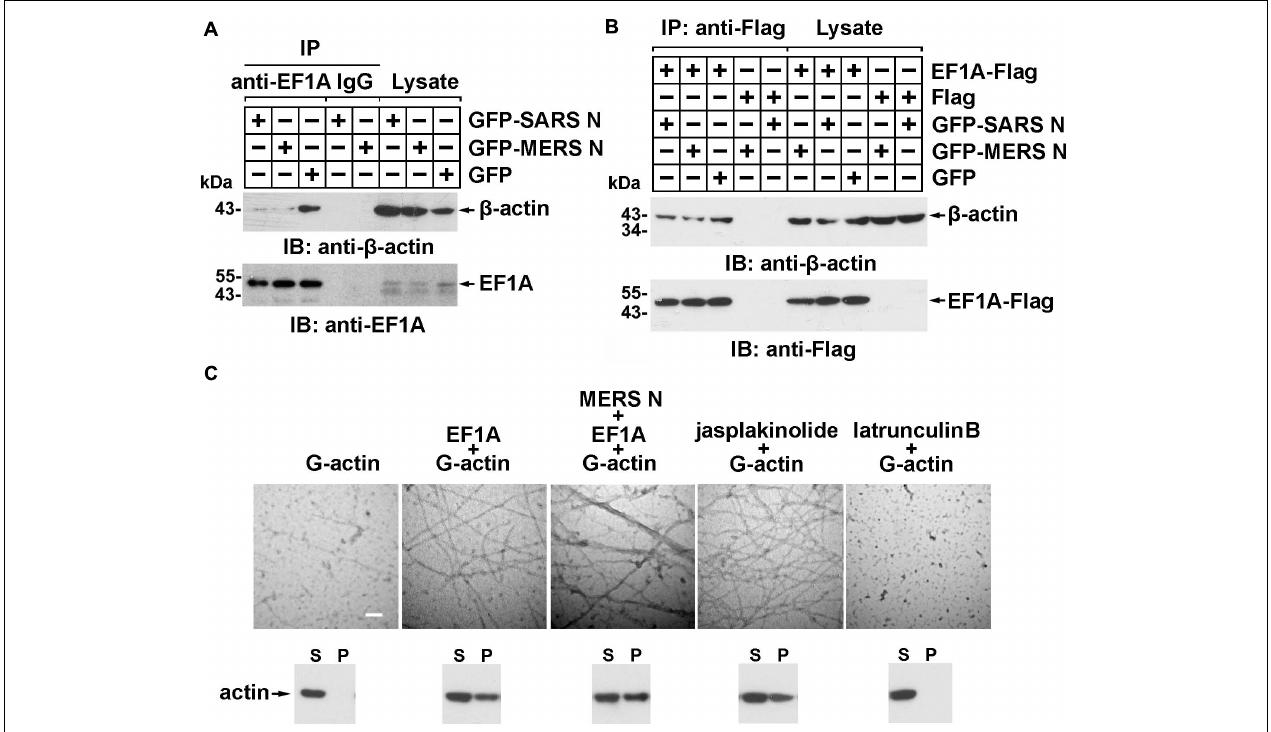
FIGURE 4 | The MERS-CoV N protein blocks the interaction between EF1A and actin and disturbs actin bundling. (A) Lysates prepared from HEK293T cells transfected with plasmids expressing GFP-SARS-CoV N, GFP-MERS-CoV N, or GFP protein were incubated with an EF1A antibody and protein A/G agarose beads. The immunoprecipitates were detected by immunoblotting with the indicated antibodies. (B) Lysates prepared from HEK293T cells cotransfected with plasmids expressing GFP-tagged N proteins and Flag-tagged EF1A protein were incubated with anti-FLAG M2 magnetic beads. The immunoprecipitates were detected by immunoblotting with the indicated antibodies. (C) An in vitro actin polymerization assay was performed. G-actin (0.5 µ M) was incubated with the indicated purified proteins at 4 ◦ C overnight. The products of the actin polymerization assay were mounted on copper grids and subjected to negative staining. The samples were observed with a Hitachi H-7650 transmission electron microscope at an accelerating voltage of 80 kV. The scale bars represent 100 nm. The polymerized actin (pellet, P) and monomeric actin (supernatant, S) in each product above were also separated by centrifugation and analyzed using immunoblotting. Jasplakinolide (1 µ M) and latrunculin B (1 µ M) were used as positive and negative controls,